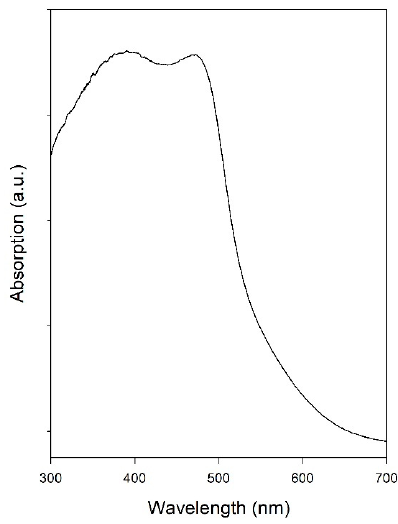
Fig. 7 UV-vis spectrum of BiVO 4. Figure 7. UV-vis spectrum of BiVO 4.